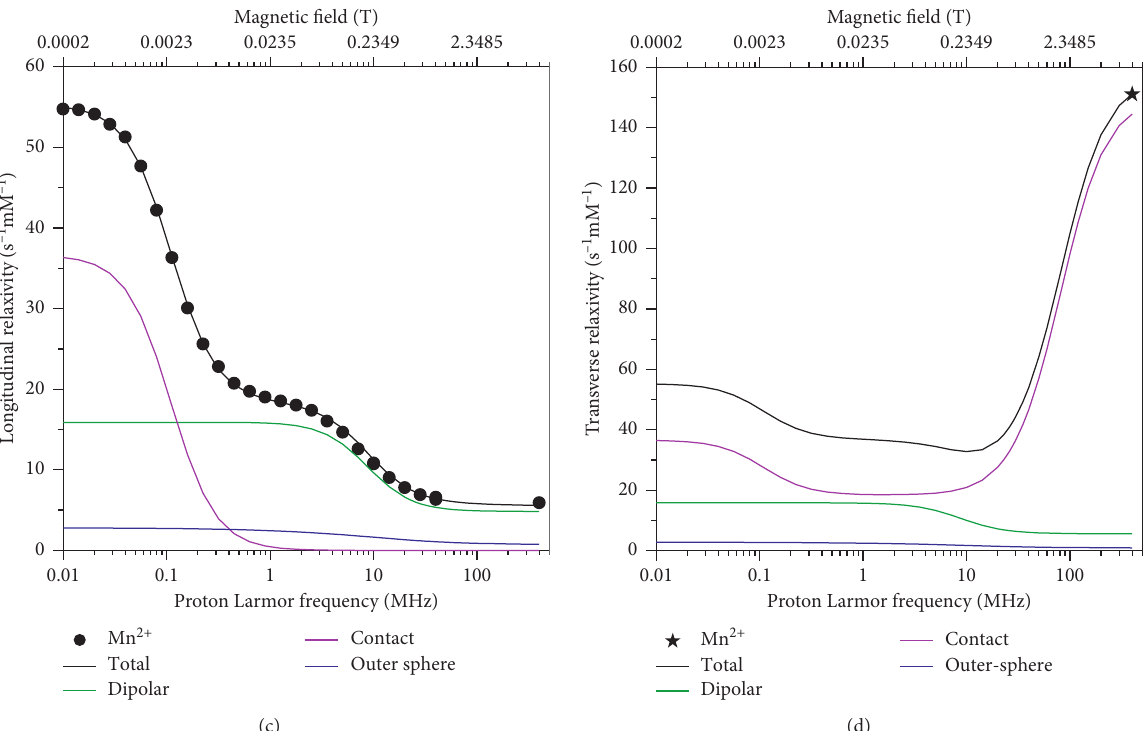
Figure 3: 1 H longitudinal relaxivity (a, c) and transverse relaxivity (b, d) at 25 ° C and their dipolar, Fermi-contact, and outer sphere contributions in pineapple juice (a, b) and in Mn 2+ solution (c,